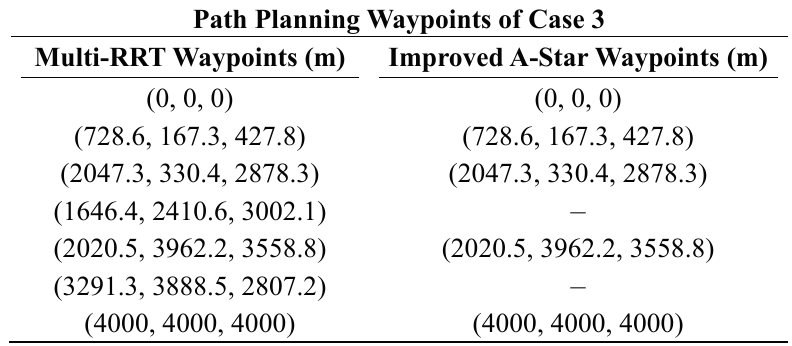
Figure 14. Path planning result of the multi-RRT and A-star algorithms and the finalized path after introducing Bezier curves in Case 3 (unit: m). ( a ) The finalized path collides with obstacles; ( b ) The finalized path avoids the obstacles. Table 3. Waypoints of the paths generated by the multi-RRT and improved A-star